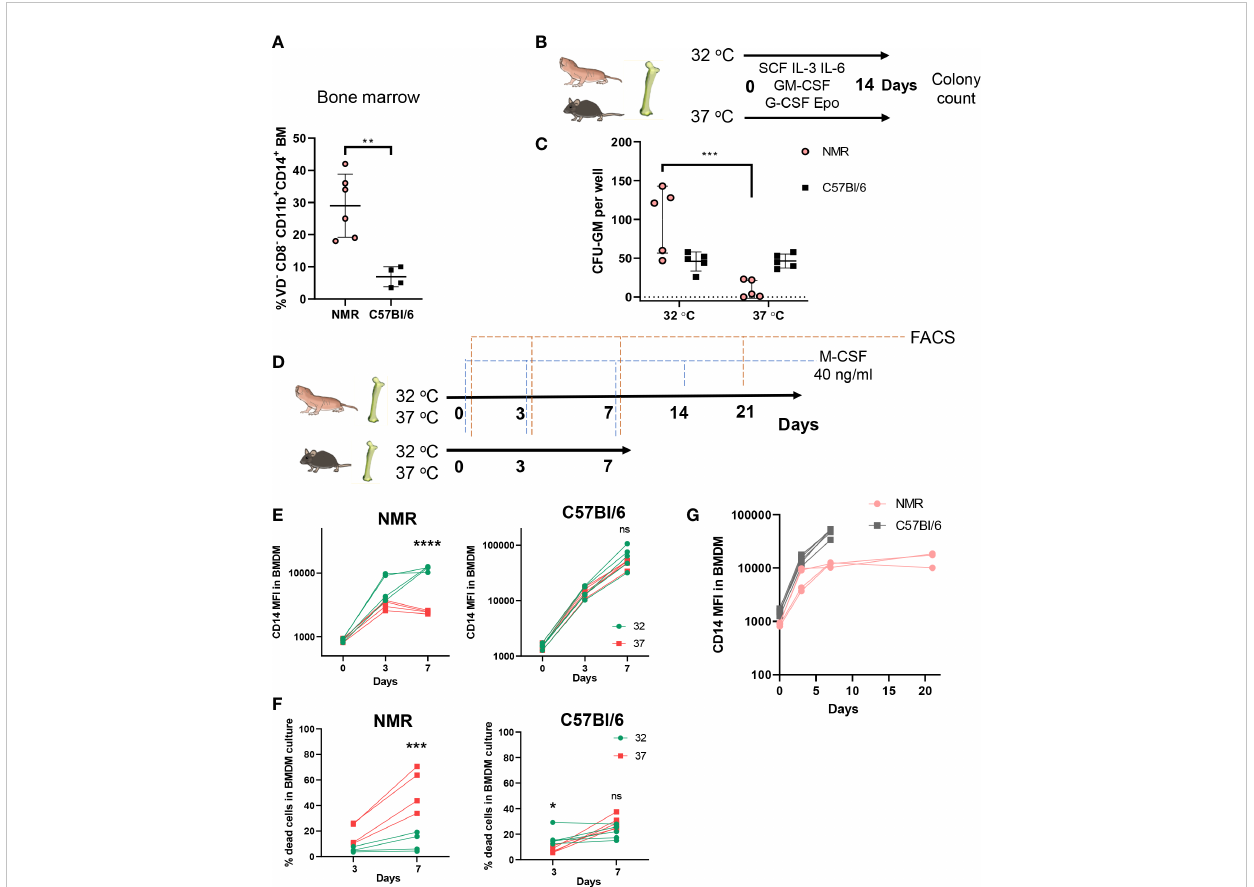
FIGURE 1 Cellular composition of hematopoietic organs and susceptibility of myeloid progenitors to temperature suggests unique adaptations of NMR myeloid cells. (A) Percent of myeloid CD11b + CD14 + cells in bone marrow of NMR and C57Bl/6 mouse; (B) The ability of NMR BM progenitors to differentiate at two temperatures was determined by CFU-C assay: non-lysed BM cells were seeded in semiliquid medium with growth factor mixture and cultured for 14 days at 32°C and 37°C, CFUs were identi fi ed by morphology and counted at the day 14; (C) CFU-GM count at day 14 and 32°C or 37° C in NMR and C57Bl/6 mouse bone marrow cultures; (D) Cells, isolated from NMR and mouse BM, were seeded in recombinant mouse M-CSF- containing DMEM/10%FBS medium and cultured for 7 days at 32 and 37°C. In two experiments NMR cells were cultured at 32°C for 21 days. Fresh medium was added to cells at days 3, 7, 14, 18. FACS analysis of BMDM cultures was performed at days 0, 3, 7, 21. (E) CD14 MFI on live CD11b + cells at days 0, 3, 7 during NMR or mouse BMDM maturation at 32°C (green) or 37°C (red). (F) Percent of dead cells stained with Viability Dye at days 0, 3, 7 during NMR or mouse BMDM maturation at 32°C (green) or 37°C (red). (G) CD14 MFI on CD11b + cells during BMDM maturation at day 0, 3, 7, 21 for NMR and day 0, 3, 7 for murine cells. Results displayed as mean ± SD.**p<0.01 Student ’ s unpaired t-test; *p < 0.05; ***p < 0.001; ****p < 0.0001; ns, not signi fi cant, two-way RM ANOVA, S ̌ idak ’ s multiple comparisons